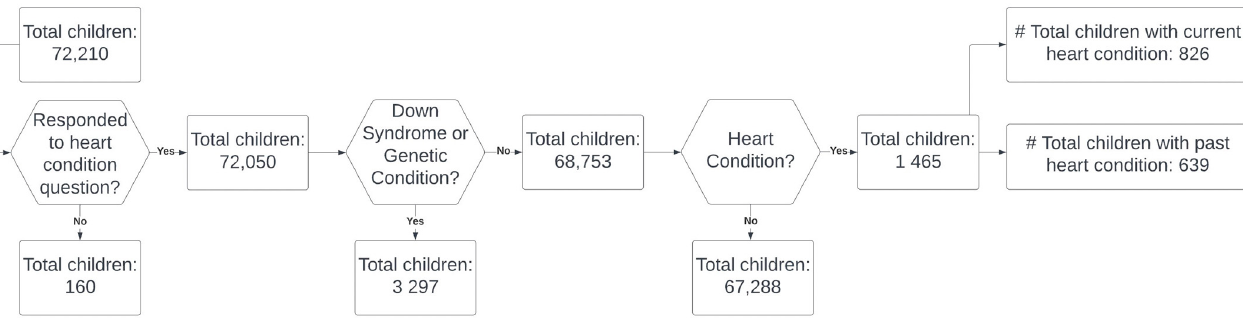
Figure 1. Flow chart of the sample included from the 2019–2020 National Survey of Children’s Health.